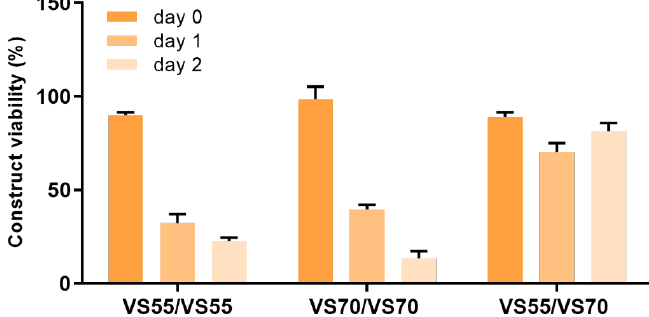
Figure 5. Construct viability using lower concentrations of load/unload solutions. Constructs were either loaded and unloaded with solutions based on the concentration of the vitrification solutions or the load/unload solutions used were at a lower concentration than the vitrification solutions. Viability was measured using the resazurin assay and is the mean ( ± SEM) of ≥ 8 replicates. Statistical analysis performed by one-way ANOVA and Tukey’s multiple comparison